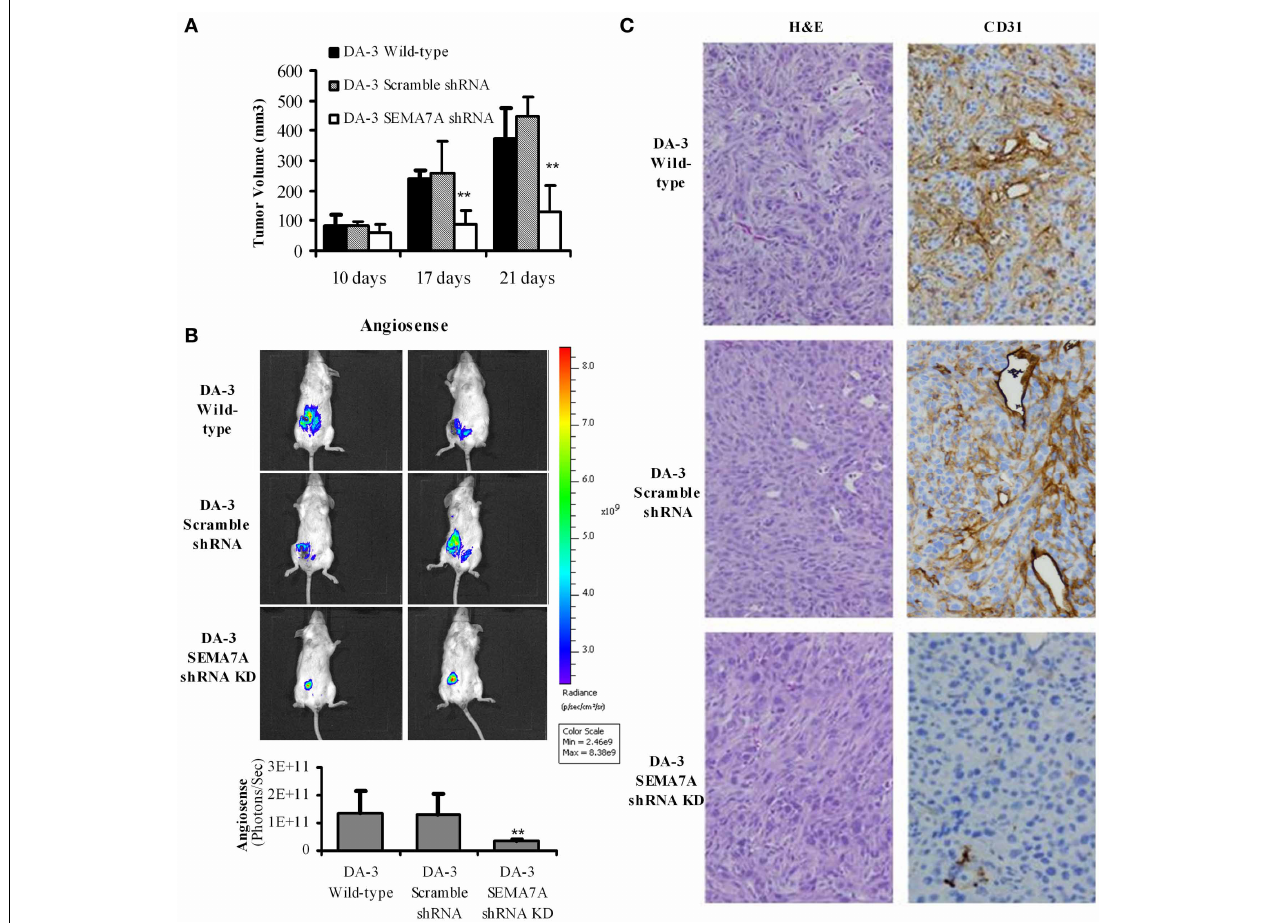
FIGURE 5 | Decreased tumor growth and angiogenesis in mice bearing SEMA7A silenced mammary tumors. (A) Tumor volume is decreased in mice bearing SEMA7A shRNA knockdown DA-3 mammary tumor compared with either wild type or SEMA7A scramble shRNA DA-3 mammary tumors; (B) ventral image of DA-wild type, SEMA7A scramble shRNA DA-3 or SEMA7A shRNA knockdown DA-3 mammary tumor